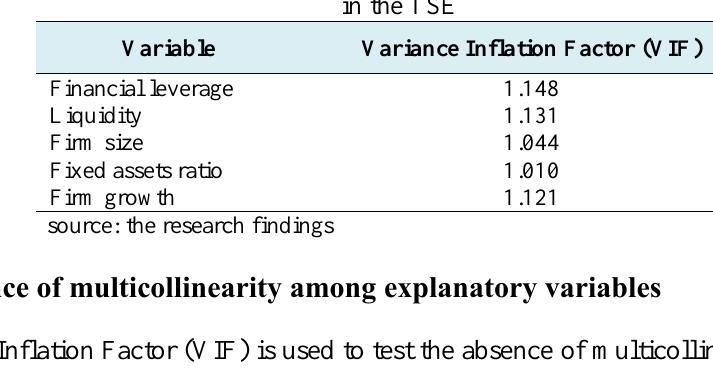
Table 8. The results of testing the absence of multicollinearity among explanatory variables in the model